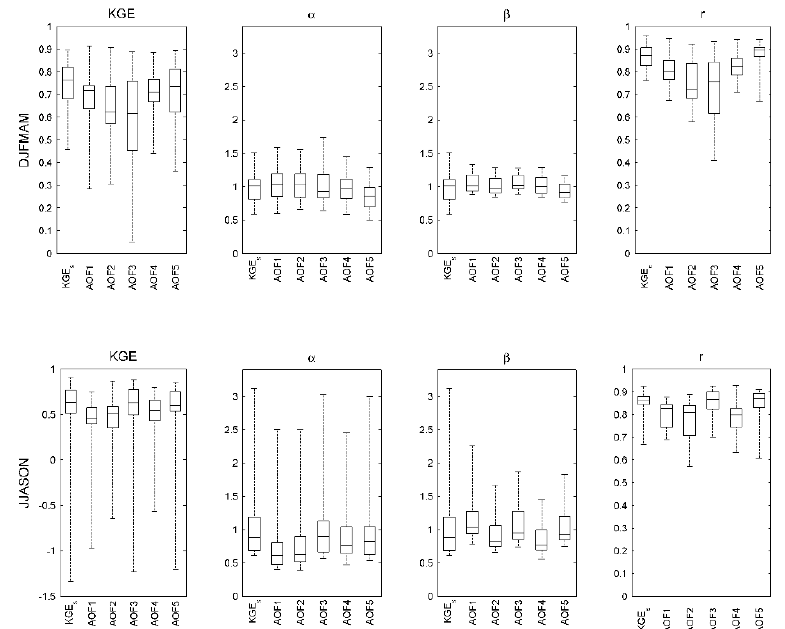
Figure A3. Hydrologic annual performance over the validation period for the De l’Achigan catchment (see Figure 6 for further description).